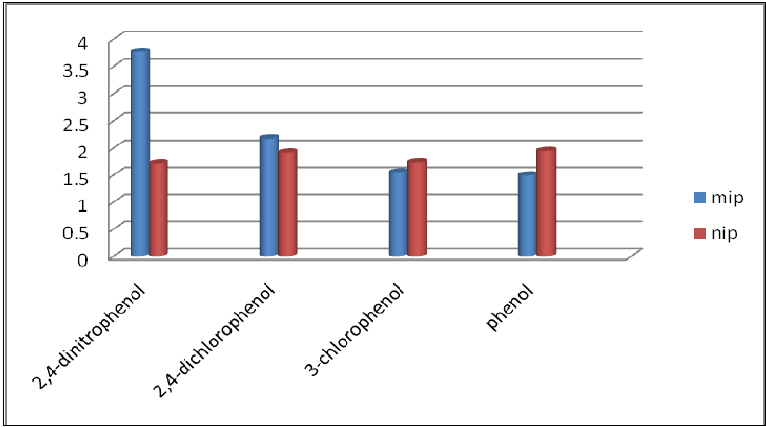
Figure 11. Selectivity study of 2,4-dinitrophenol by MIP in the presence of various phenolic compound.